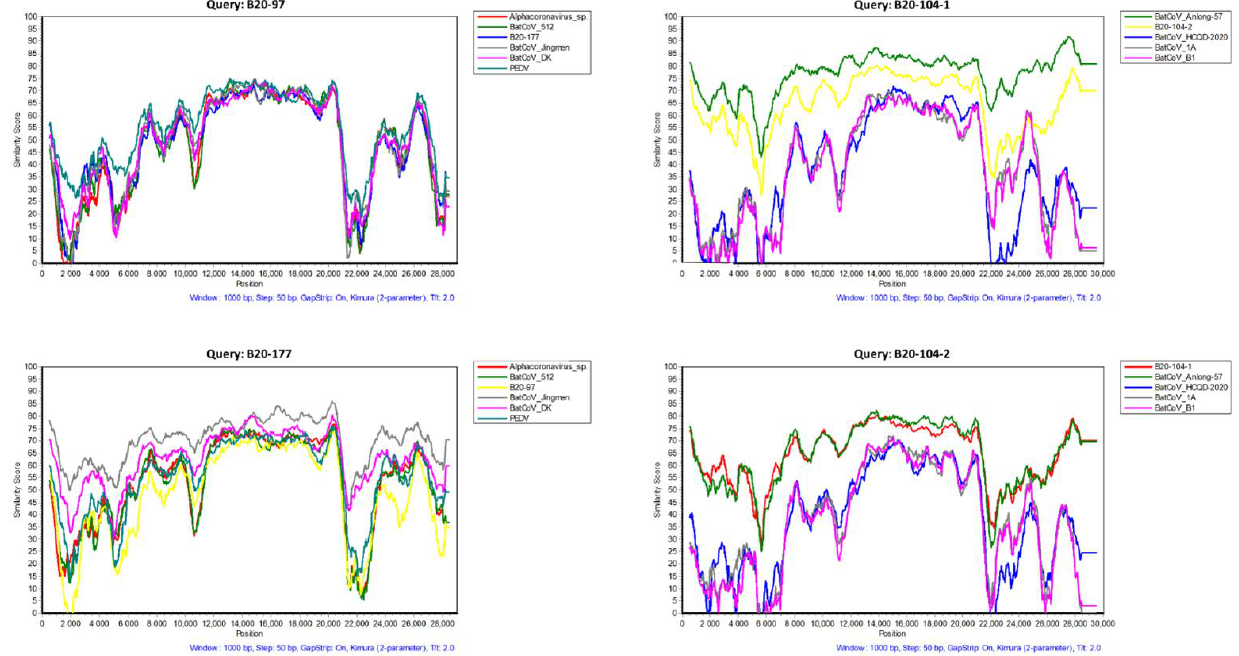
Figure 2. Genomic sequence identities between newly described bat CoVs and other closed αCoVs.